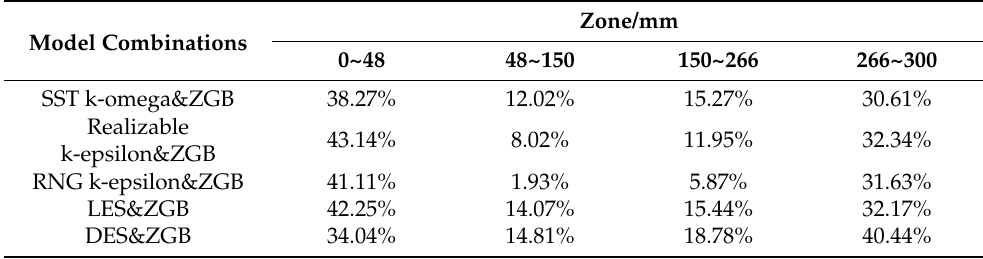
Table 5. The error of average cross-sectional x 1 flow rate at 55 bar differential pressure compared to test data.